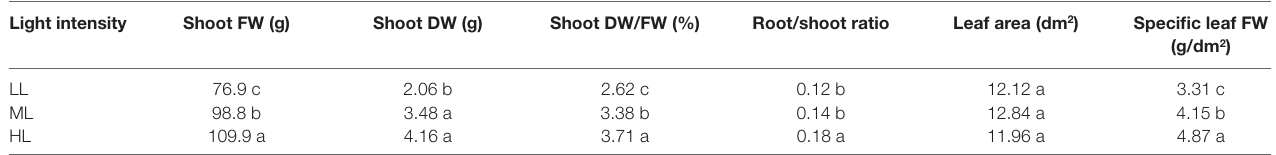
TaBLe 2 | The shoot fresh weight (FW), shoot dry weight (DW), shoot DW/FW, root/shoot ratio, leaf area, and specific leaf FW of lettuce plants grown under continuous light of different light intensities: low light (LL, 100 μmol·m −2 ·s −1 ), medium light (ML, 200 μmol·m −2 ·s −1 ), and high light (HL, 300 μmol·m −2 ·s −1 ). Light